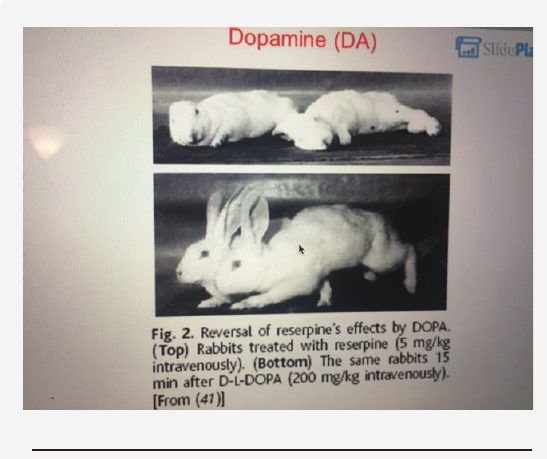
Figure 1. Reversal of reserpine’s effects by DOPA. (Top) Rabbits treated with reserpine (5 mg/kg intravenously). (Bottom) The same rabbits 15 min after D-L-DOPA (200 mg/kg intravenously). [From